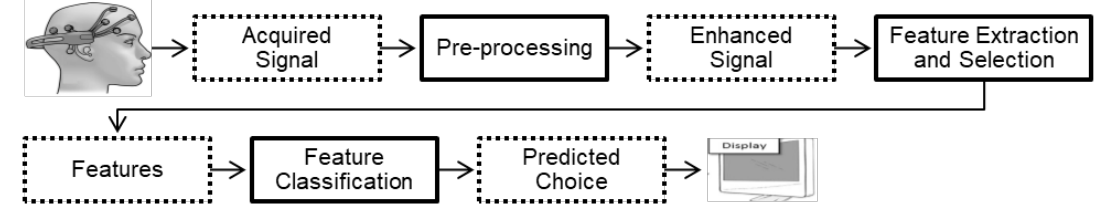
Figure 3. EEG-based consumer preference prediction